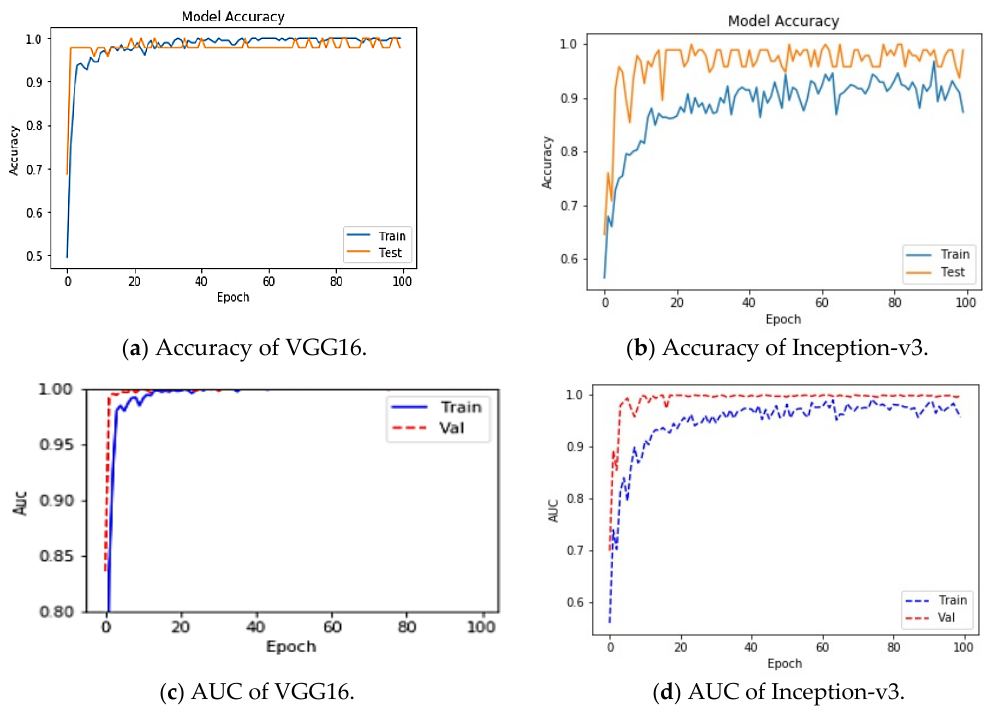
Figure 4. Accuracy and AUC of transfer learning models for COVID-19 detection from chest X-rays.